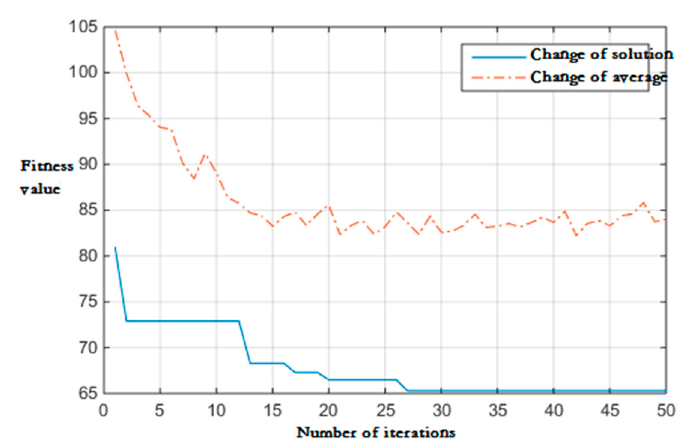
Figure 8. Multi-objective algorithm search